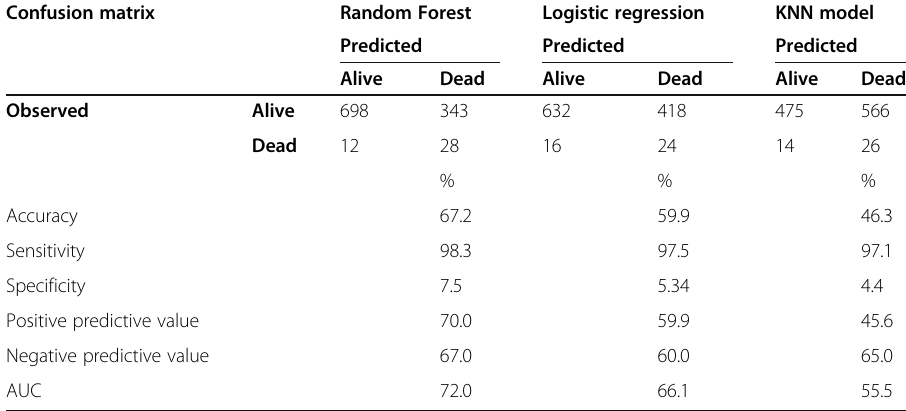
Table 2 Model accuracy metrics for all models as evaluated on the test data Confusion matrix Random Forest Logistic regression KNN model Predicted Predicted